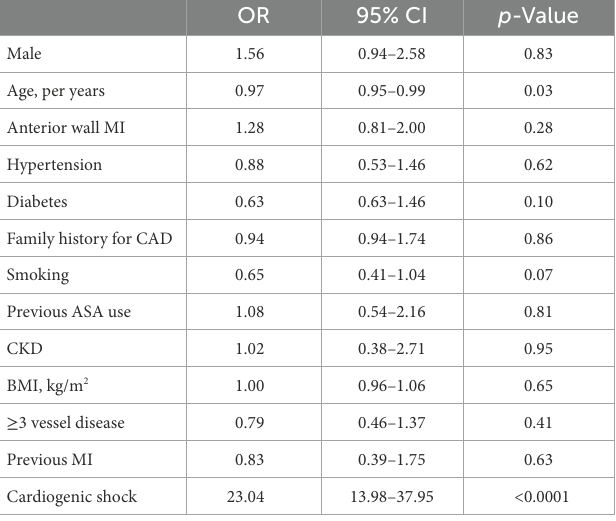
TABLE 3 Variables associated with pre-PCI sudden cardiac arrest in multivariate analysis. OR 95%